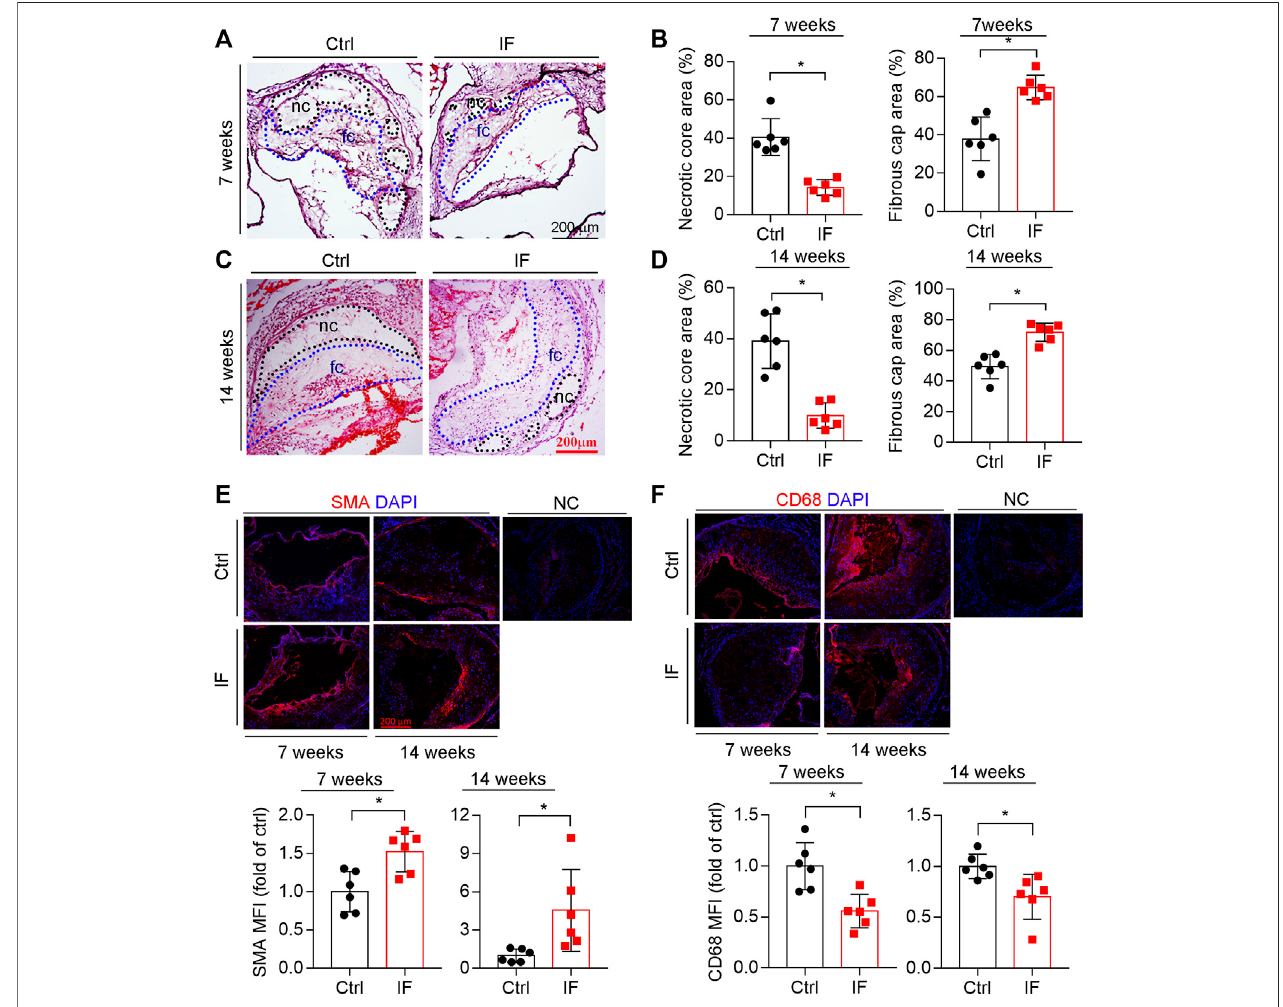
FIGURE 2 | Intermittent fasting increases lesion plaque stability. The aortic root cross sections were used to complete the following assays: HE staining (A,C) with the quantitative analysis of necrotic core and fi brous cap areas (B,D) . nc: necrotic cores marked by a black dotted line; fc: fi brous cap marked by a blue dotted line. The expression ofSMAand CD68 (E,F) inplaquesweredeterminedbyimmuno fl uorescentstainingwiththequanti fi cationofSMA-orCD68-positive areas.* p < 0.05(n (cid:1) 6).